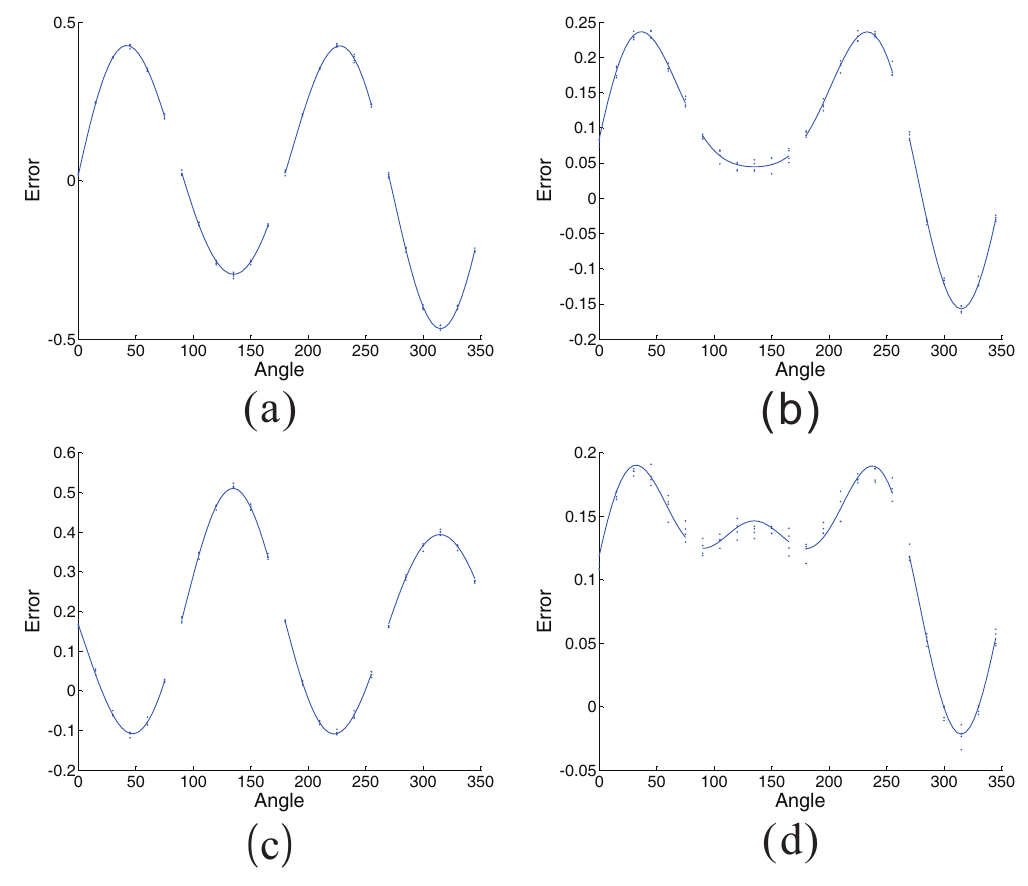
Figure 14. The performance of the error diagnosis method in different cases. The situations ( a ), ( b ), ( c ), ( d ) are used to acquire error parameters. The discrete points are four groups measuring errors in the same situation, while the curves are drawn using the output error parameters.